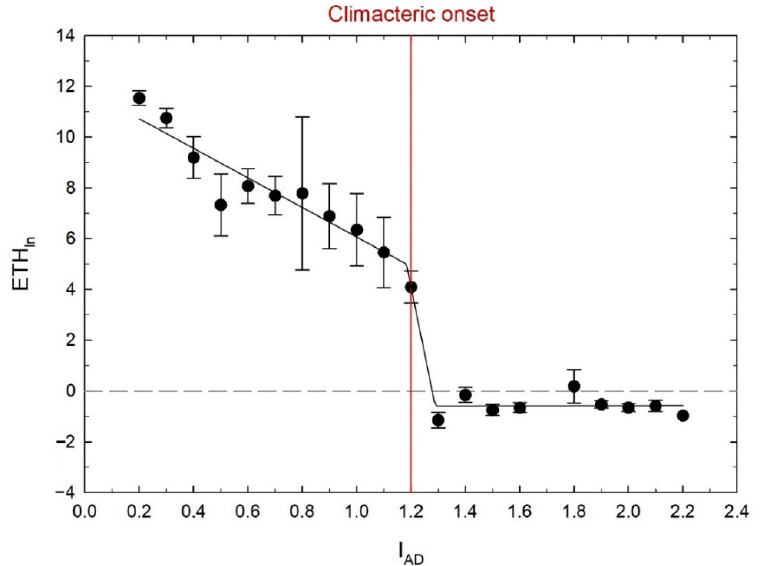
Figure 8. Natural logarithms of ethylene emission (ETH ln ) and corresponding Index of Absorbance Difference (I AD ) in a sample of 123 ‘Majestic Pearl’ nectarine fruit collected at different times before and after harvest in 2020–2021. The horizontal dashed line shows ETH ln = 0, whereas vertical error bars represent standard errors of ETH ln . The fit is characterised by a piecewise regression with a three-segment line. The vertical red line represents the identified I AD threshold for climacteric